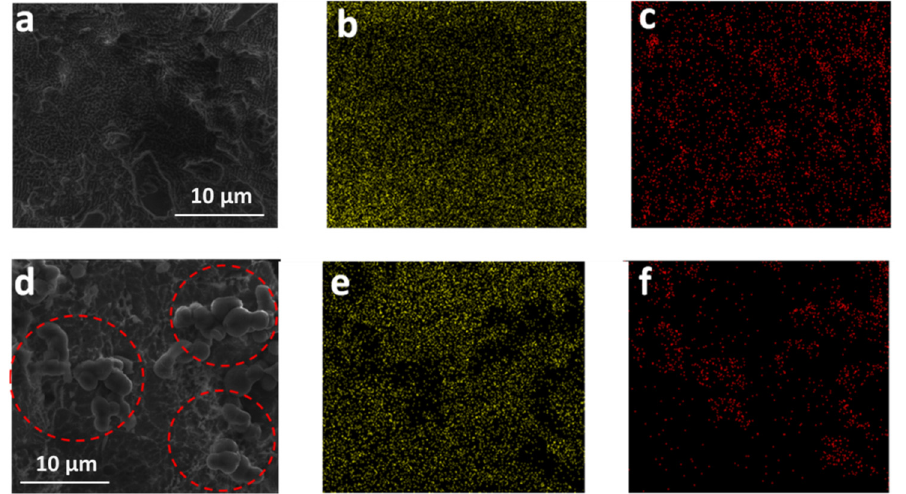
Figure 5. ( a ) SEM image of β -cyclodextrin derived carbon on the surface of sulfur; ( b ) Elemental mapping of S; and ( c ) elemental mapping of C in the region shown in ( a ); ( d ) SEM image of sucrose derived carbon on the surface of sulfur; ( e ) Elemental mapping of S; and ( f ) elemental mapping of C in the region shown in